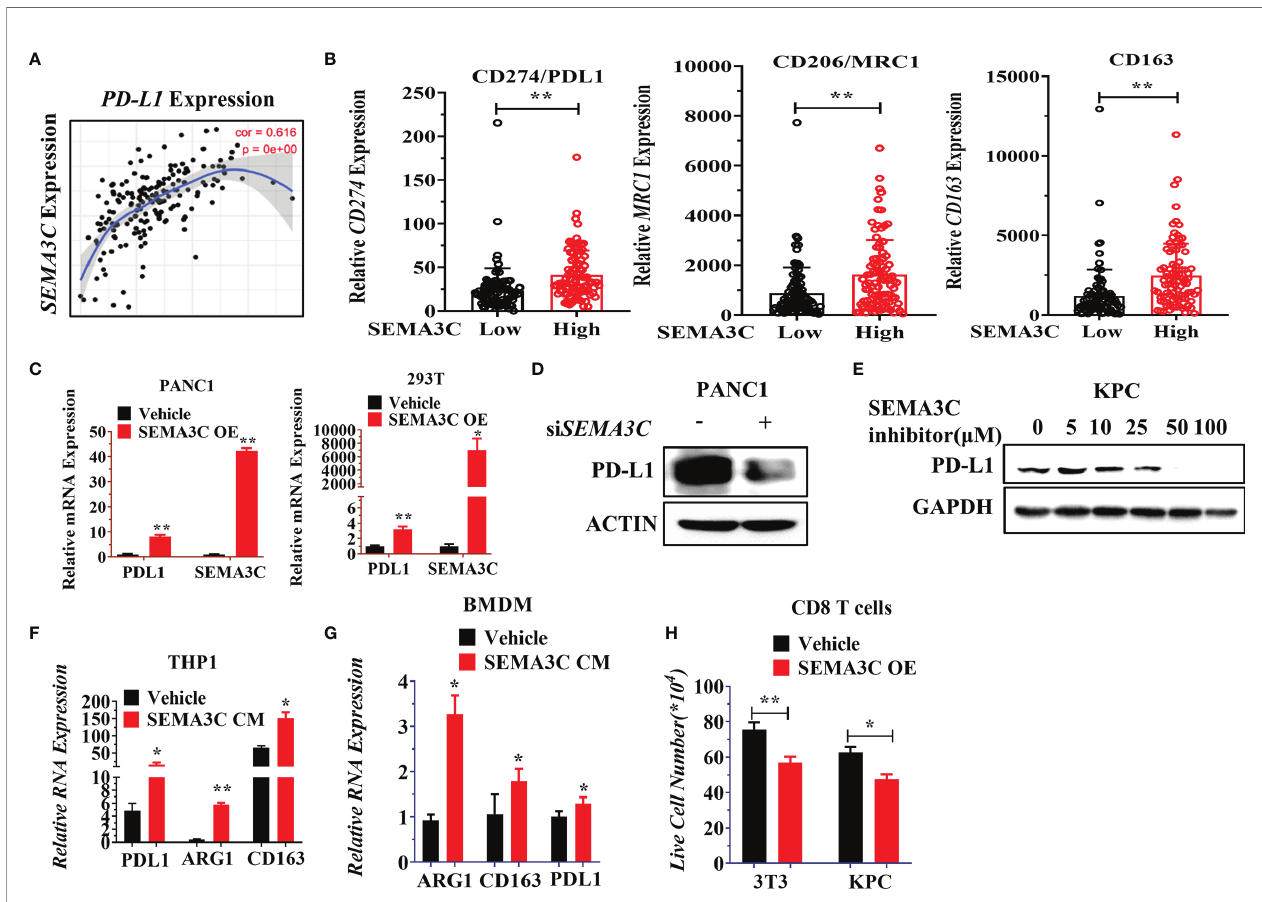
FIGURE 5 | (A) The correlation between SEMA3C and PD-L1 analyzed by Timer software. (B) PD-L1, MRC1, CD163 expression in either SEMA3C high expression or low expression groups. The groups were divided into two groups by the mean of SEMA3C in the TCGA database. (C) PD-L1 mRNA expression detected after the overexpression of SEMA3C in different cell lines. (D) PD-L1 protein expression was detected after knocking down the SEMA3C expression. (E) PD-L1 protein expression was detected after treatment of different doses of SEMA3C inhibitor in the KPC cell line for 24 hours. (F) Expression of PD - L1, ARG1, and CD163 were detected by qPCR in THP1 cells after being treated by the conditional medium derived from either PANC1 cells or PANC1 cells overexpressing SEMA3C. (G) Expression of PD-L1, ARG1, and CD163 were detected by qPCR in BMDM cells after being treated by the conditional medium derived from KPC cells or KPC cells overexpressing SEMA3C. (H) Activated CD8+ T cells co-cultured with normal 3T3 and KPC cells or 3T3 and KPC cells with overexpressed SEMA3C for 24 hours before the suspended T cells number were counted. The error bars indicate the SD of three independent experiments: *P < 0.05, **P <